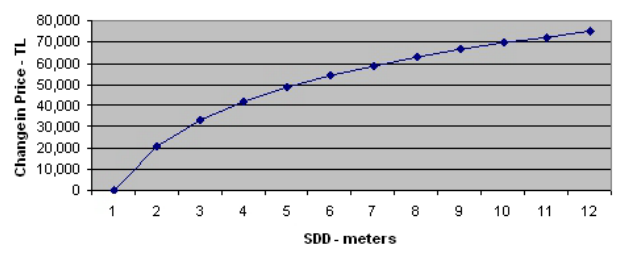
Fig. 11. The logarithmic relationship between SDD and real-estate value as obtained from Equation